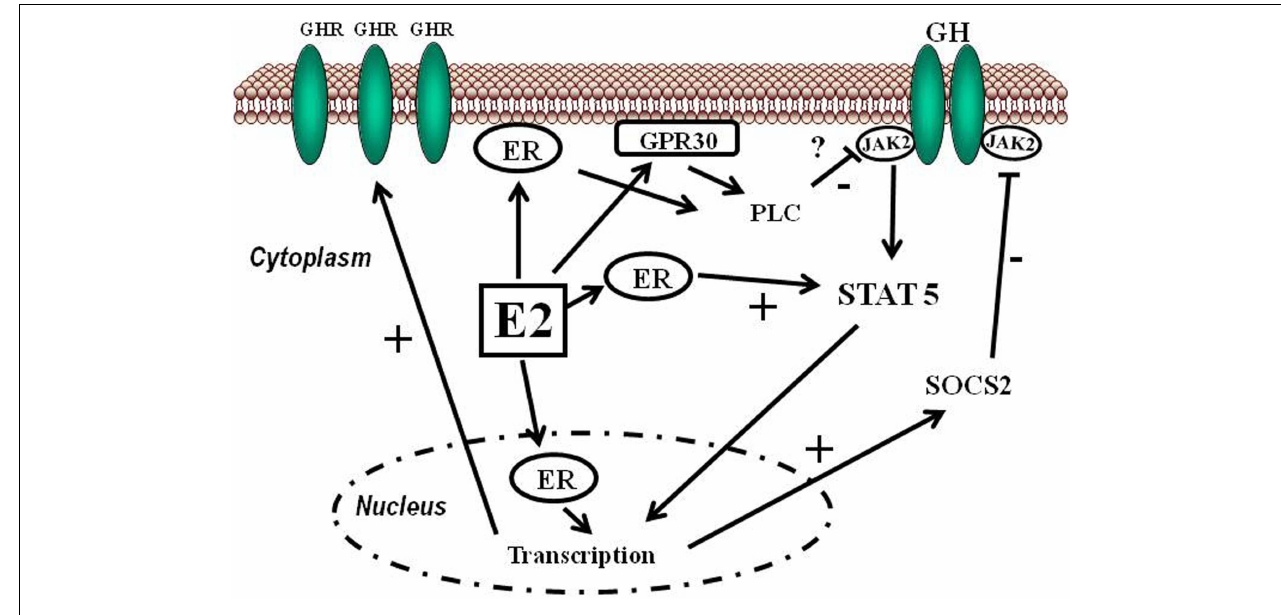
expression and crosstalk with GH-activated JAK2-STAT5 signaling pathway. Estrogens can induce SOCS2 expression which in turn negatively inhibits GHR-JAK2-STAT5 signaling